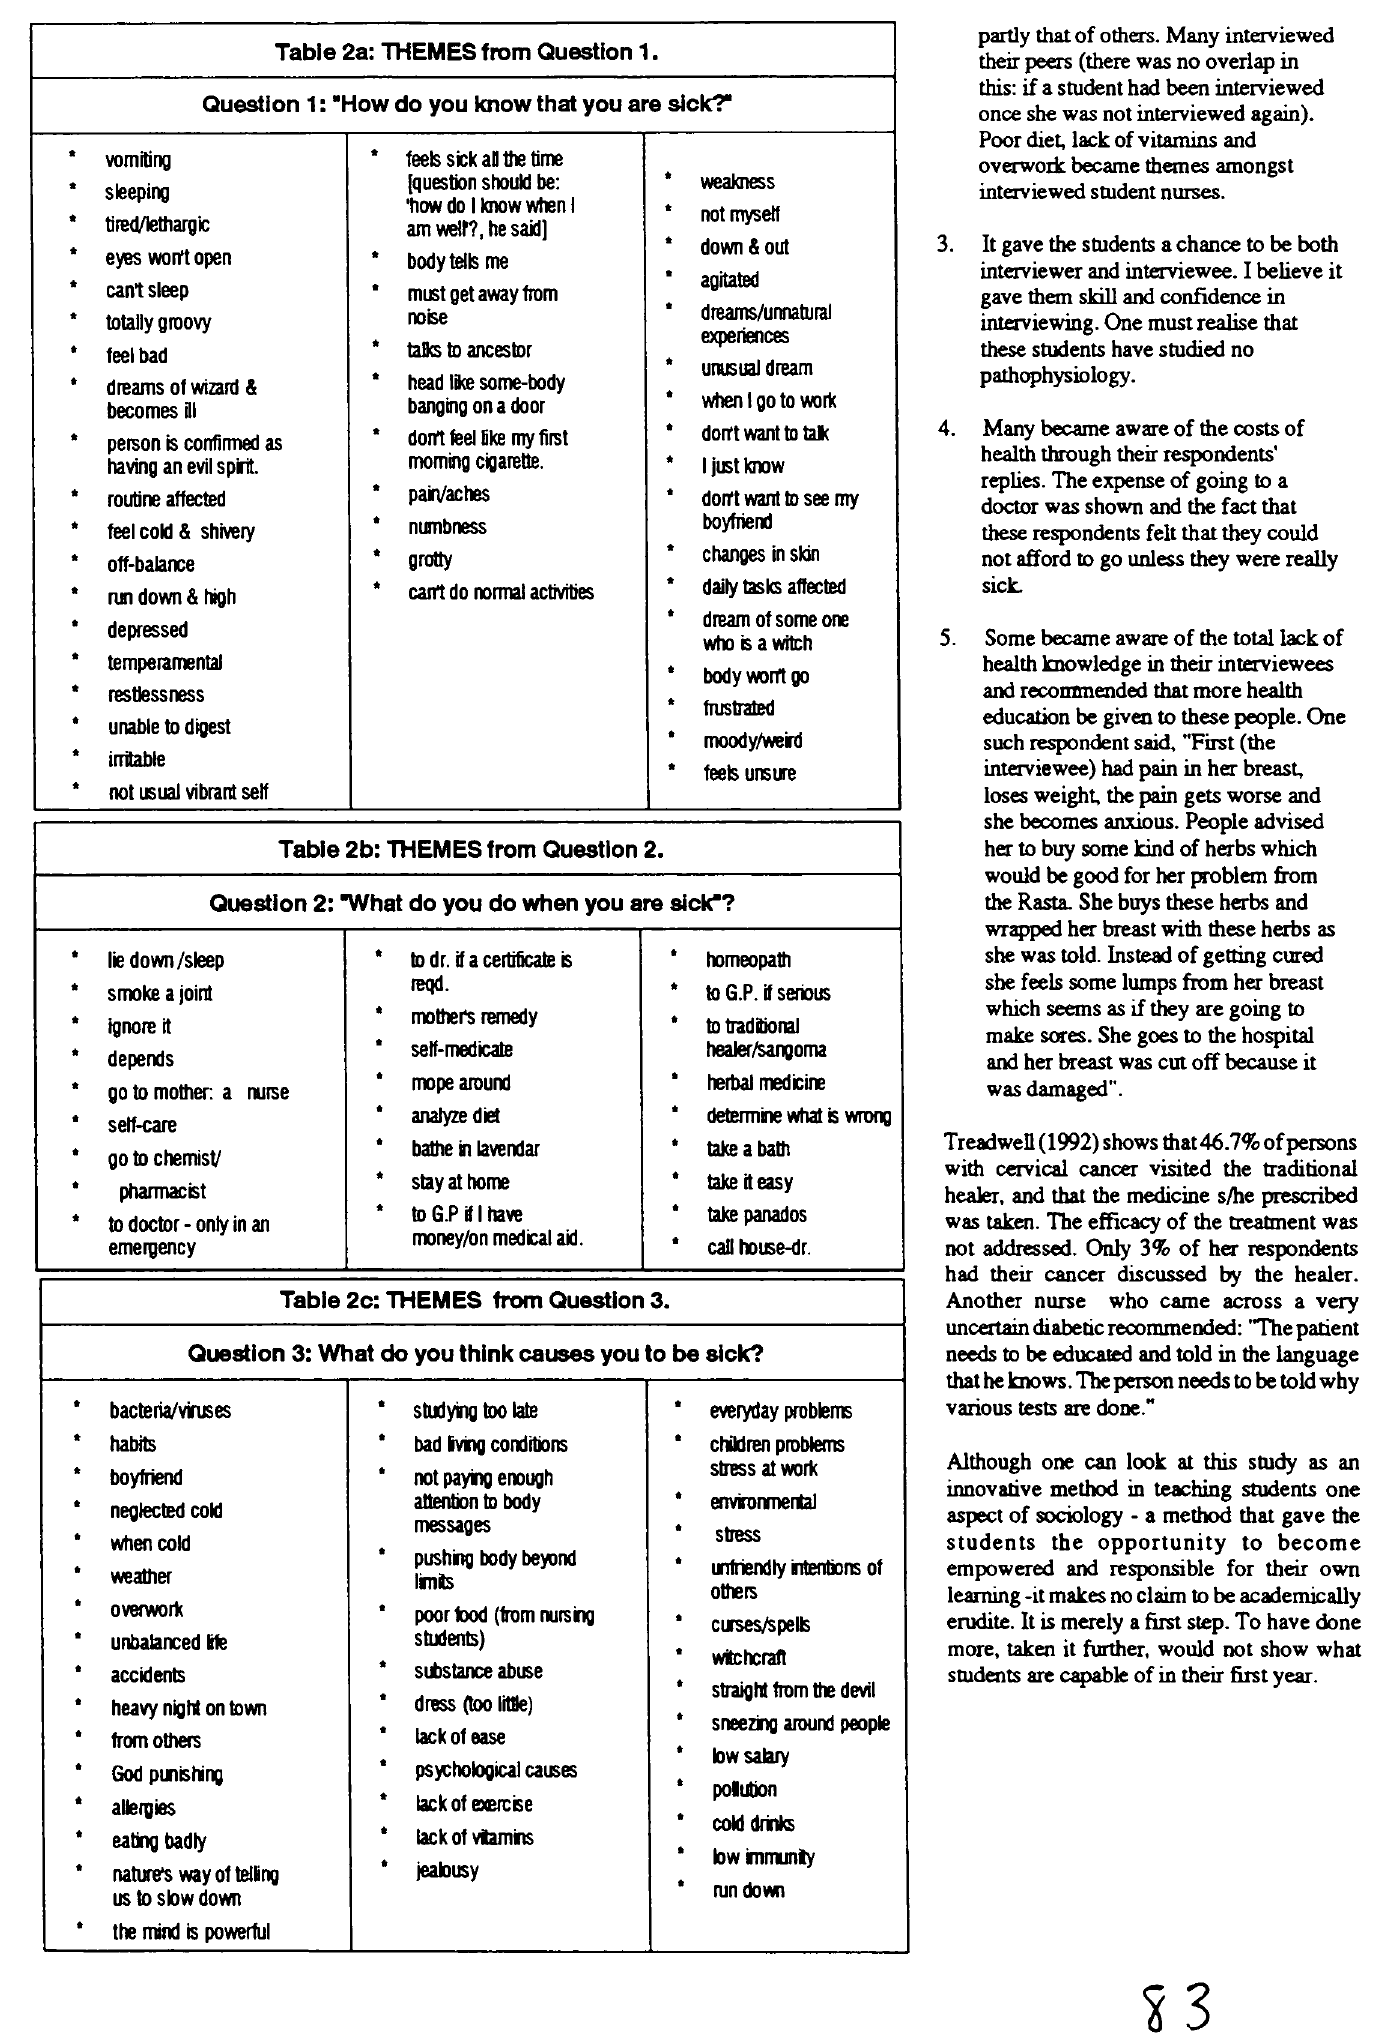
Table 2c: THEMES from Question